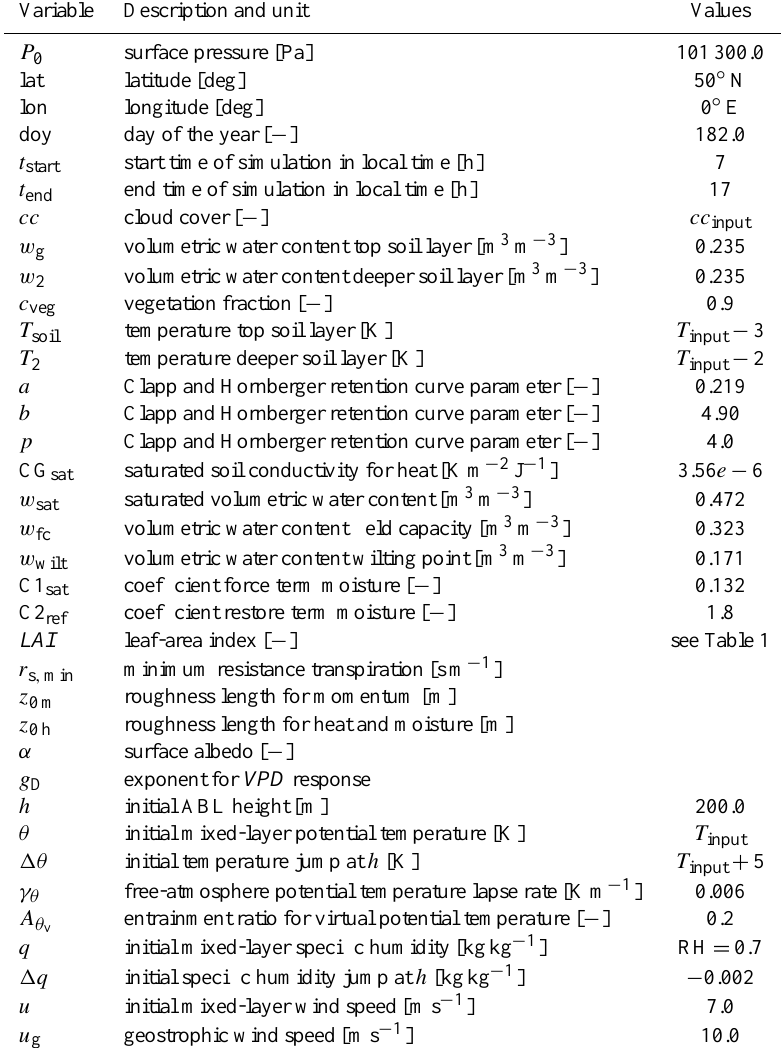
Table A1. Initial and boundary conditions for all model